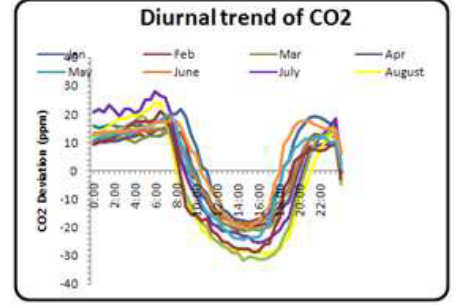
Figure 2: Observed diurnal variability of atmospheric surface layer CO 2 (deviations) at Dehradun during 2009